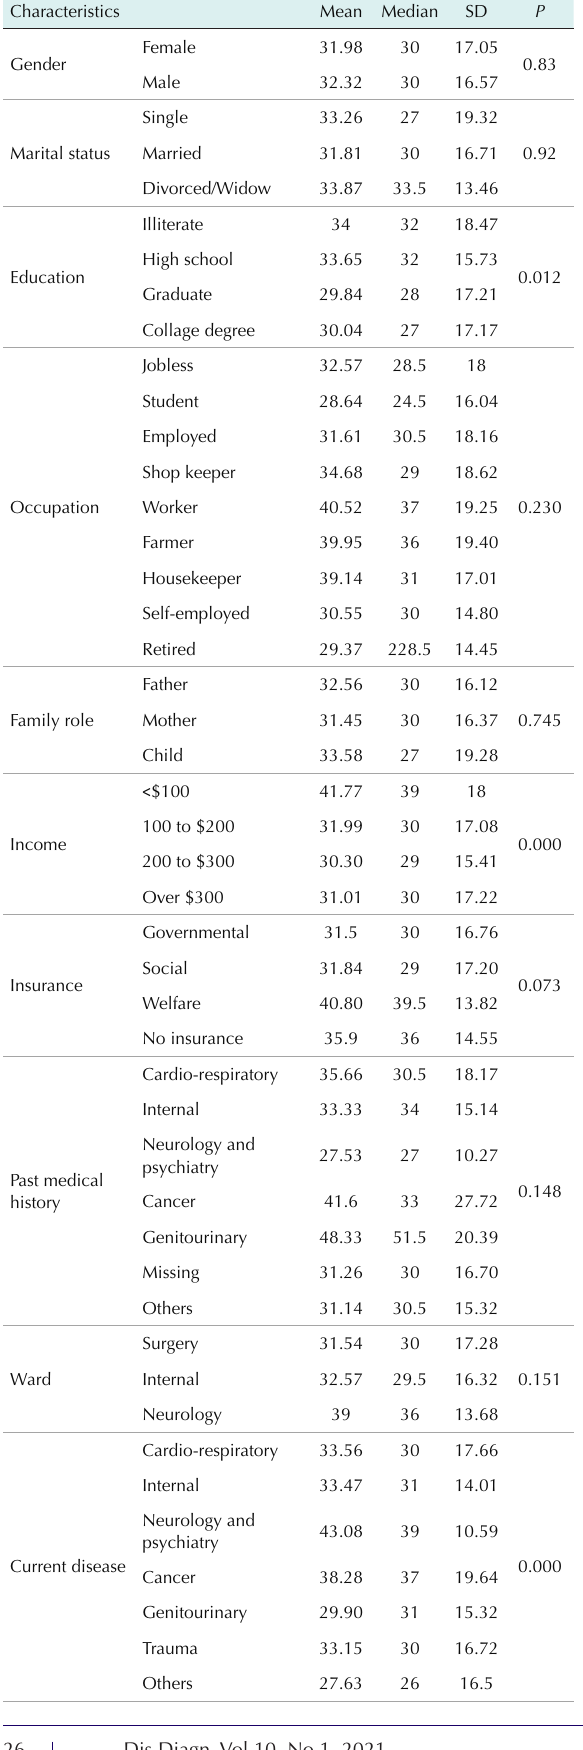
Table 2. Distribution of Patients’ Concern Score by Personal Characteristics